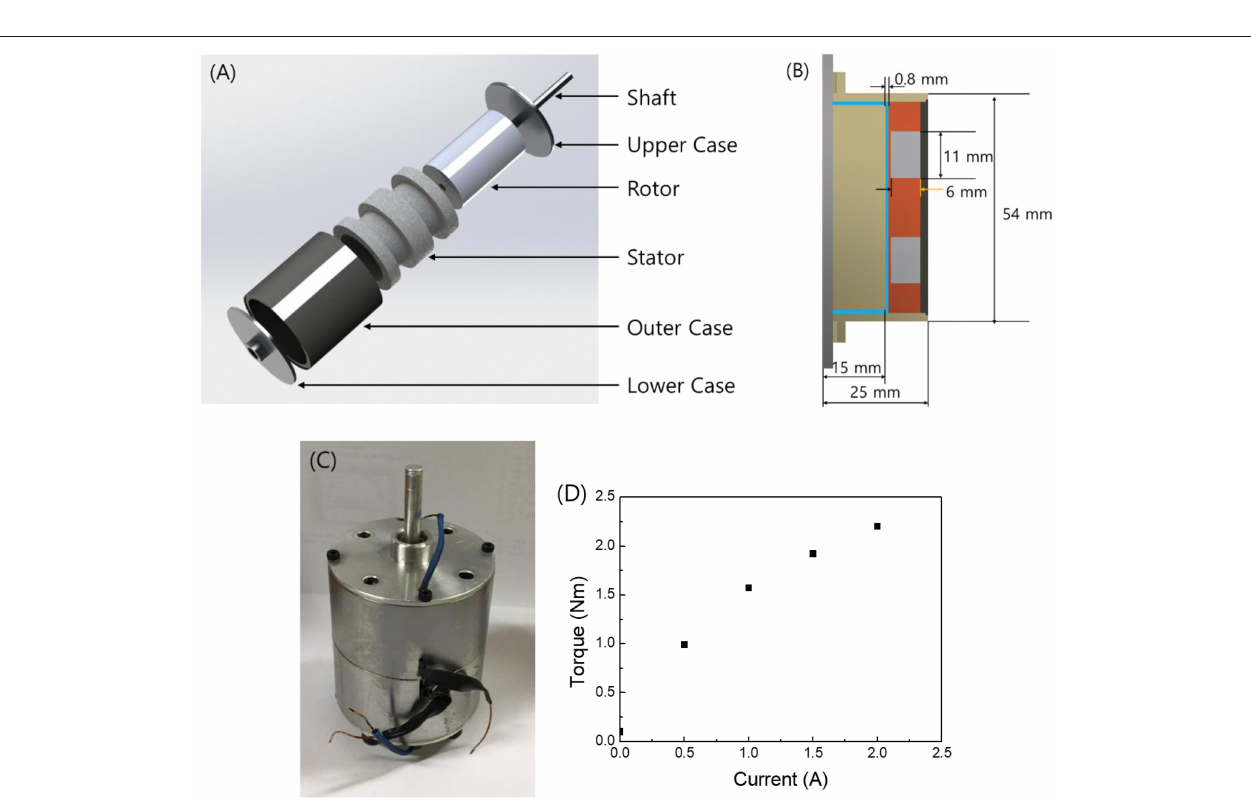
FIGURE 2 | The proposed MR brake. (A) Configuration. (B) Section view. (C) Photograph. (D) Measured